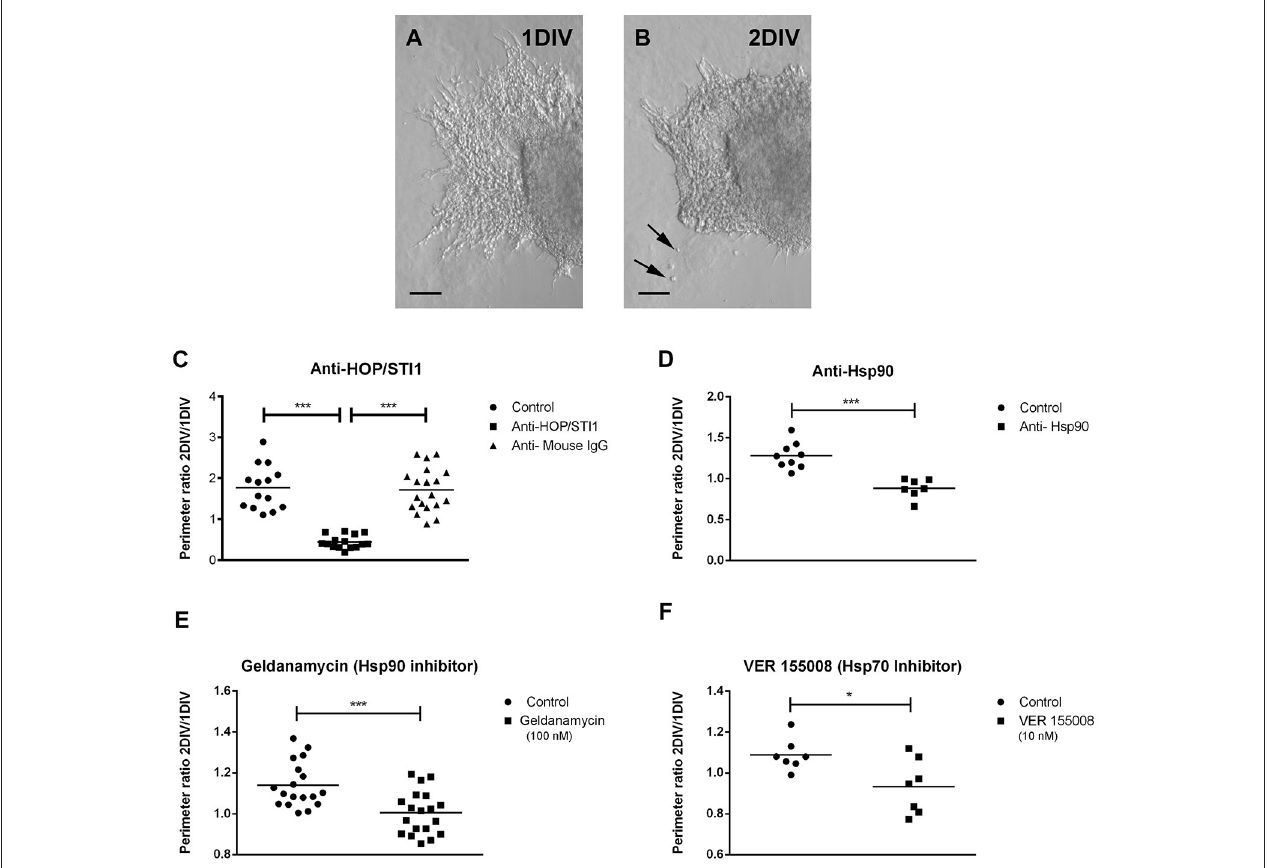
FIGURE 3 | Treatment with antibodies and inhibitors disrupt neuroblast chain migration from SVZ explants. (A) Representative bright-field images depicting extensive neuroblast migration from SVZ explant culture at 1 DIV. (B) After antibody treatment (anti-HOP/STI1) at 2 DIV, a compact mass of cells is present in the vicinity of the explant and chain organization is practically lost. Some clusters of cells are detected in the sites previously occupied by the neuroblast chains (arrows). Antibody treatment reduces the perimeter of migratory halos around SVZ explants. In (C) , a significant reduction in the ratio of 2/1 DIV perimeter obtained from explants submitted to anti-HOP/STI1 treatment was detected when compared to both control and anti-Mouse IgG treated groups (Kruskal-Wallis test, Dunn post-hoc test, p < 0.0001). (D) A similar result was observed after treatment with anti-Hsp90 antibody (Unpaired T -Test, p < 0.001, n = 4). Migratory halos were also reduced after treatment with Hsp90 inhibitor Geldanamycin ( E , unpaired T -test, p < 0.001) and VER155008, which inhibits Hsp70 ( F , Mann-Whitney test, p < 0.05). * p < 0.05, *** p <